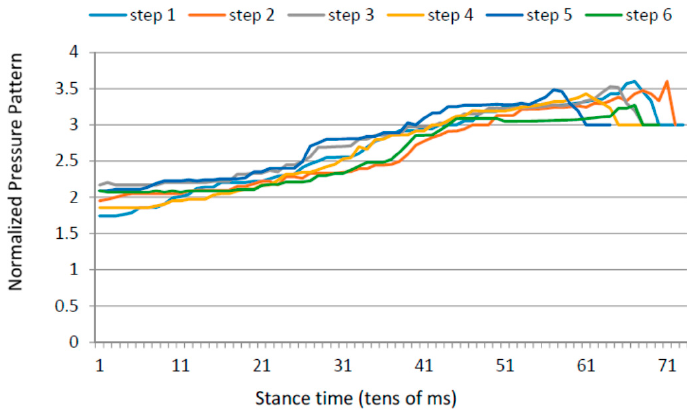
Figure 12. Anterior/posterior centre of pressure in the first six steps for a stroke survivor.